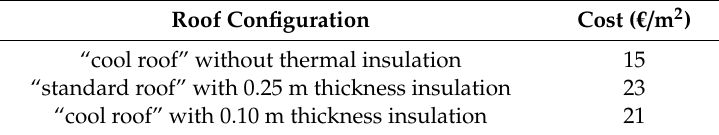
Table 7. Comparison of construction cost for three example roof